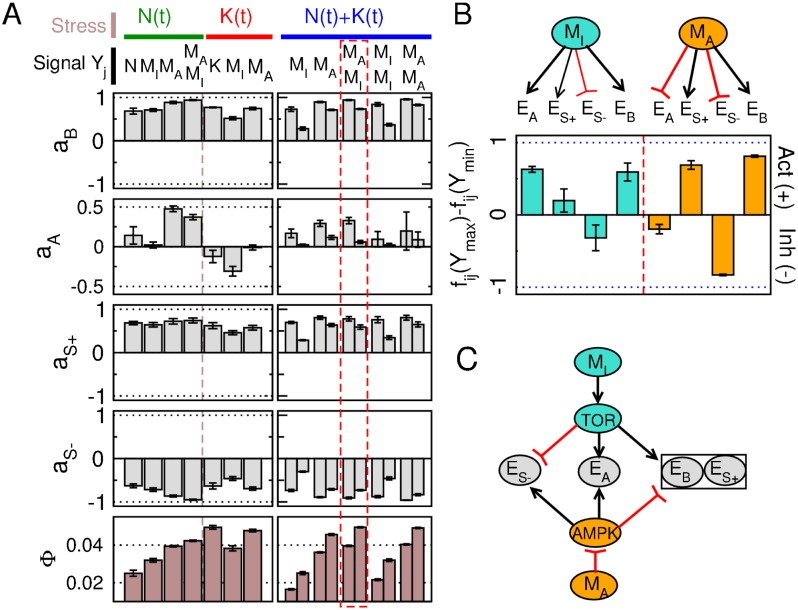
Optimal signaling and regulatory pattern of enzymes in response to single or combined stress conditions.Case where rate coefficients Ei(t) are regulated by optimized signaling pathways (Eqs 7 and 8). (A) Enzyme amplitudes (Eq 9): average and variance values computed for the 20 best solutions overs 40 evolutionary runs. Evolutionary optimization is made on the regulatory parameters μi, λij and θij for two distinct and combined stress conditions (N(t): N0 = 1, ω = 0.01, aN = 0.7, aK = 0; K(t): N0 = 1, ω = 0.01, aN = 0., aK = 3.5) and for various signals. For optimization in combined stress conditions (right panel), left versus right bars corresponds to enzyme amplitudes measured when exposed to a single stress, N(t) (left) or K(t) (right). (B) Optimal regulatory parameters fij(Ymax) − fij(Ymin) represented as activatory or inhibitory regulations in the presence of two signaling pathways and combined stress conditions (see dashed rectangle of (A)). (C) Corresponding regulatory scheme by assuming the existence of AMPK-like and TOR-like regulatory proteins.